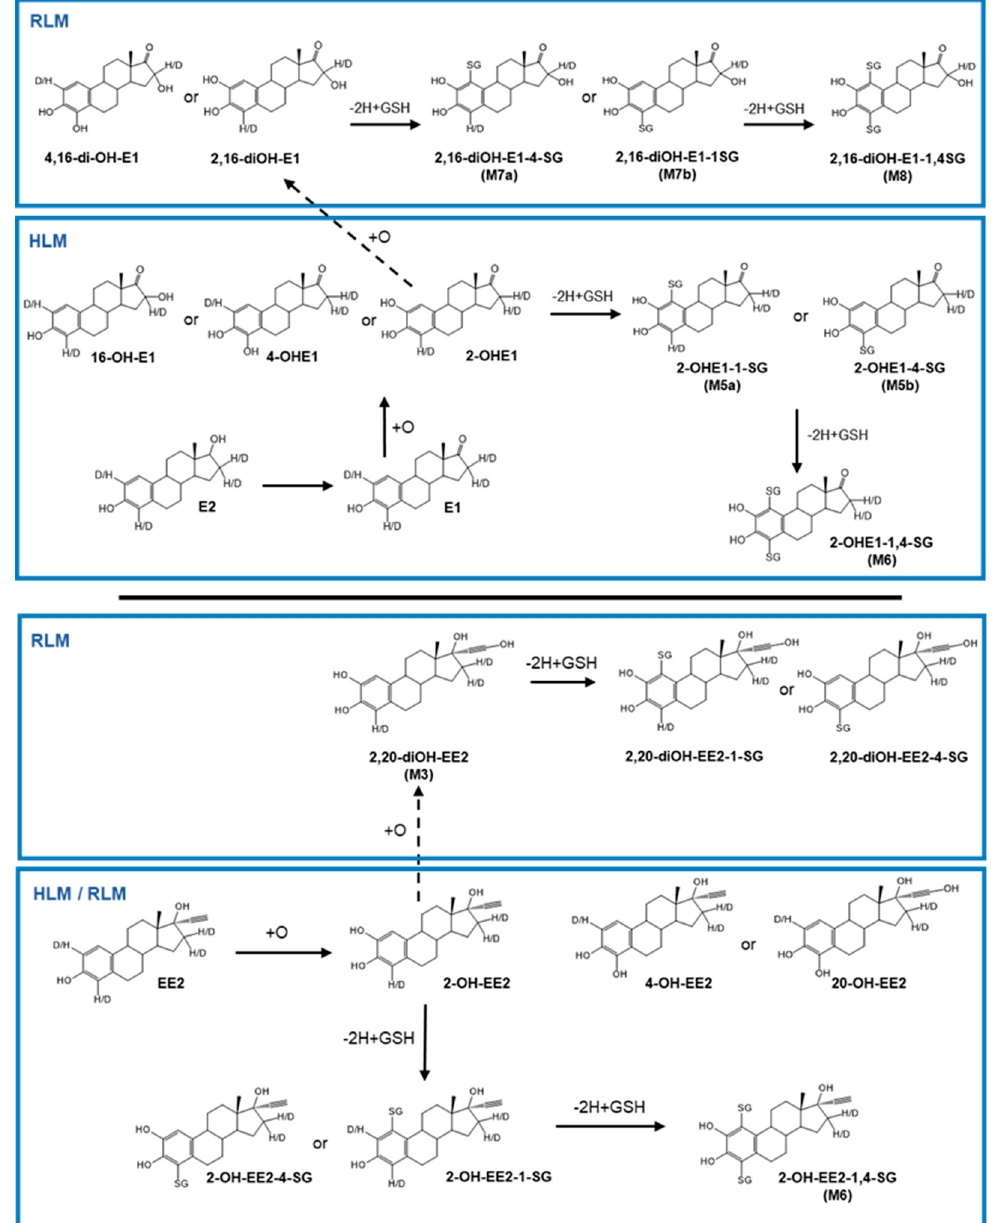
Figure 5. Proposed biotransformation reactions of unlabeled and deuterated E1, E2 and EE2 detected in human and rat microsomal incubations. As estrone and estradiol undergo similar metabolic profiles, only the structures from estrone are proposed to simplify the figure; the adduct formed with GSH can be formed with NAC. Peaks are annotated if structures could be determined for specific retention times.